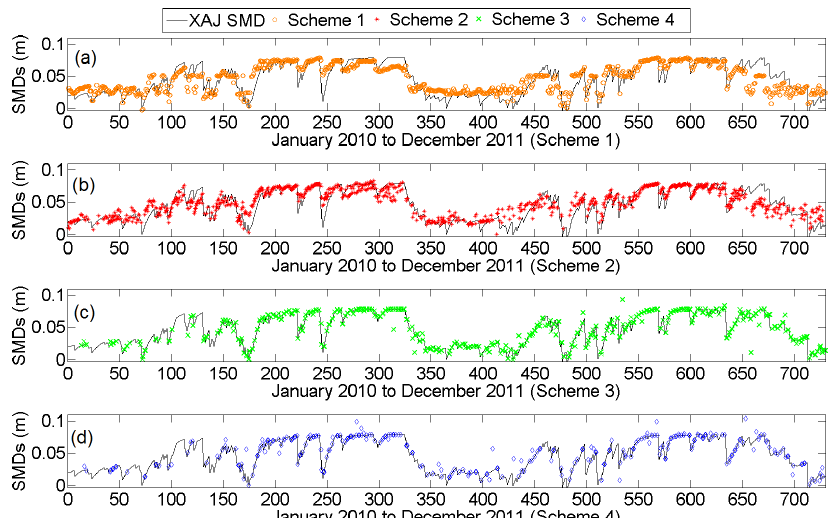
Figure 7. The time series plots of the XAJ SMD and the estimated SMD from the four schemes: (a) scheme 1, (b) scheme 2, (c) scheme 3, and (d) scheme